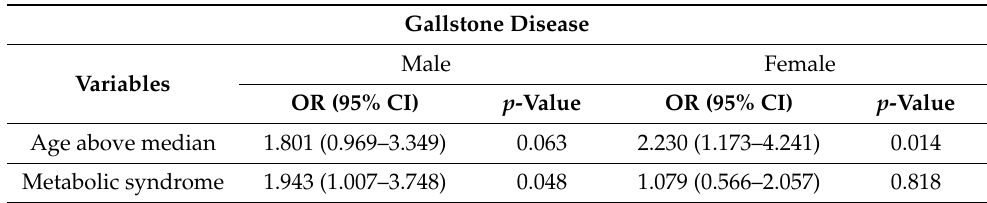
Table 4. Multiple logistic regression analysis of factors associated with gallstone disease and chole- cystectomy in males and